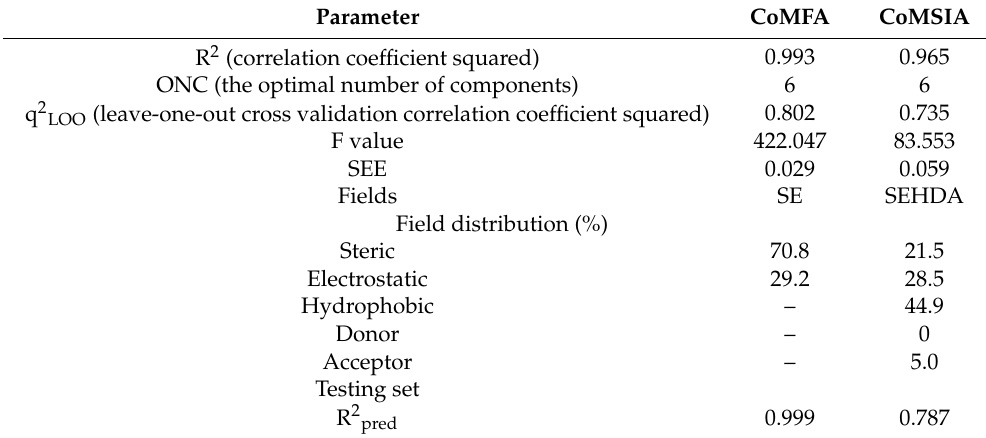
Table 6. Summary of the results obtained from CoMFA and CoMSIA analyses. Parameter